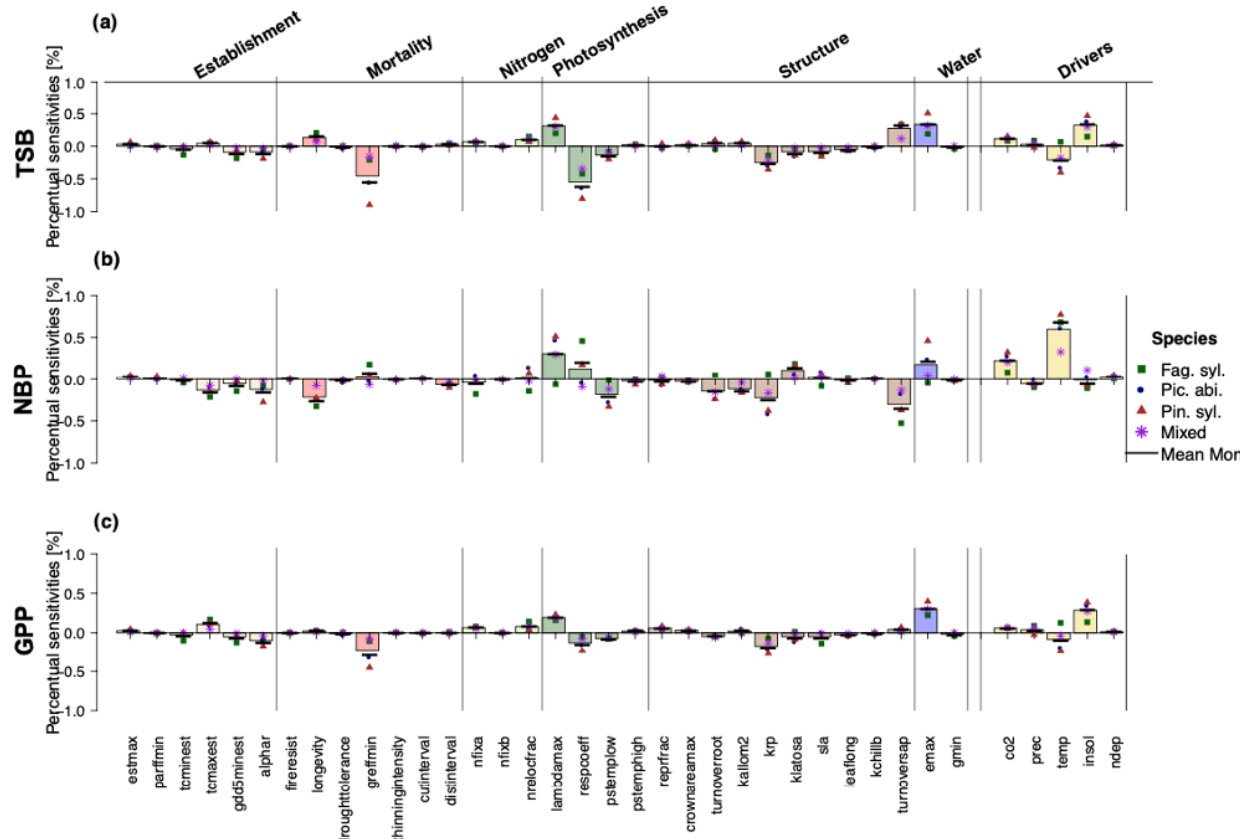
Figure 1. Relative sensitivities (percent output change per percent parameter change) of the individual parameters and environmental drivers regarding (a) total standing biomass, (b) net biome productivity, and (c) gross primary production. Sensitivities were not substantially different between Fag. syl. (green squares), Pic. abi. (blue circles), and Pin. syl. (red triangles), but parameter sensitivities were stronger for monospecific stands than mixed stands (purple asterisks). The height of the bar reflects the mean over monospecific and mixed stands. Positive values for points and bars indicate a positive and negative values a negative relationship with the corresponding